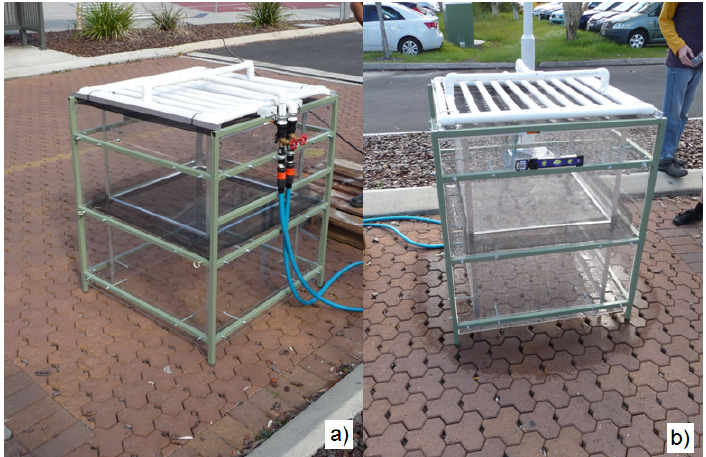
Figure 4. ( a ) Rainfall simulator; ( b ) Rainfall simulator in